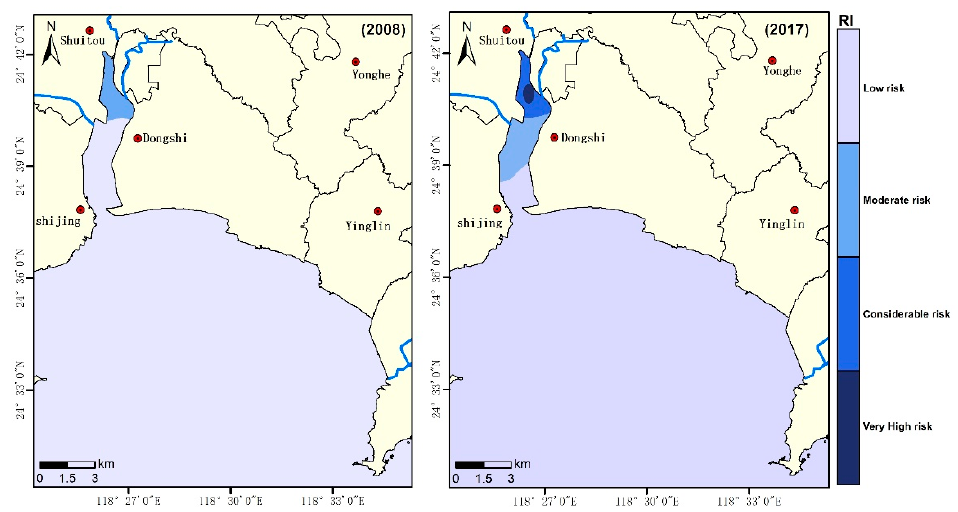
Figure 4. Spatial distribution of RI in Weitou Bay.